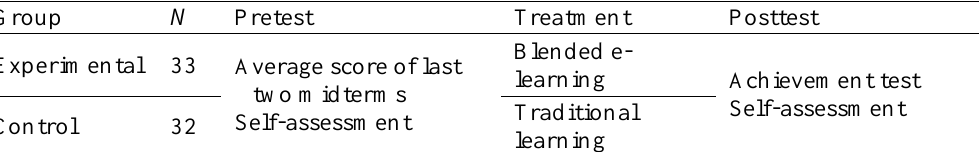
Experimental Procedure